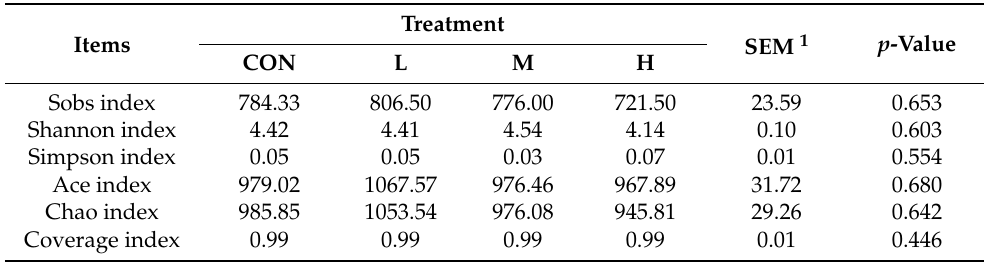
Table 6. Effects of replacing 0 (CON group), 20 (L group), 40 (M group) and 60% (H group) of maize silage with mulberry silage on lambs’ rumen microbial alpha diversity (n = 6). Items